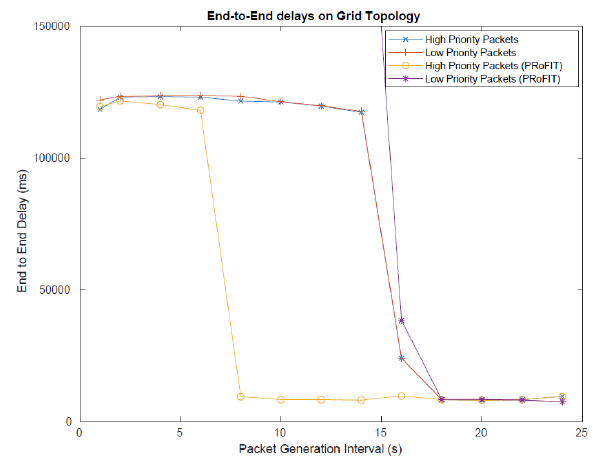
Figure 9 . End-to-End Delays on Grid